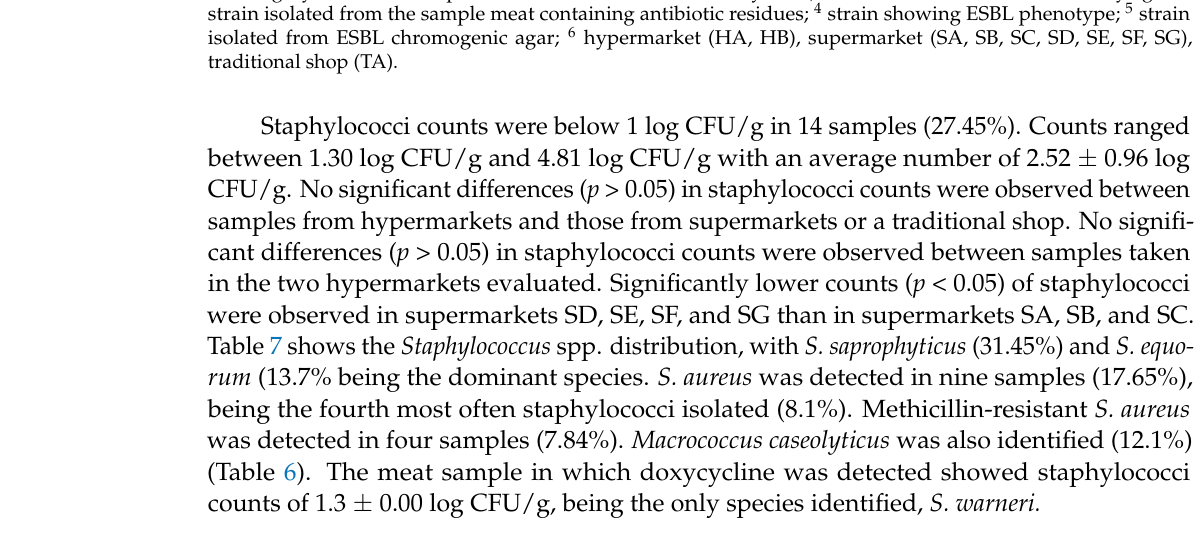
Table 7. Number and percentage of Staphylococcus spp. and Macrococcus spp. isolates identified in turkey samples recovered from mannitol salt